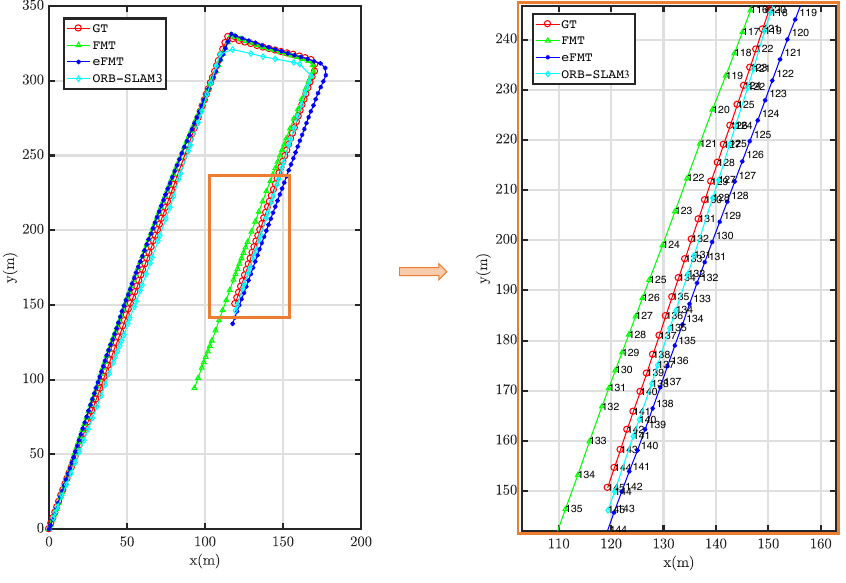
Figure 13. Estimated trajectories on the UAV dataset. SVO and DSO fail to track the